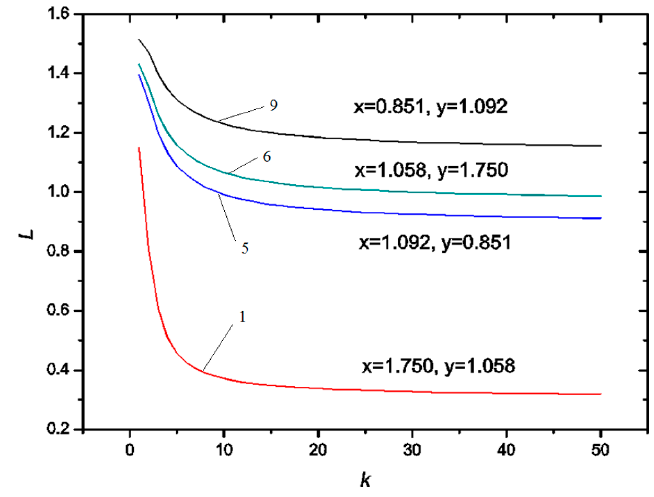
Figure 3. Variation of equilibrium position L ( L = l / R 1 ) with respect to radius ratio k ( k = R 21 / R 1 ).